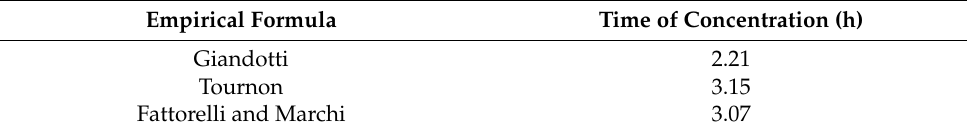
Table 3. Time of concentration for the Guerna watershed by applying different empirical formulas. Empirical